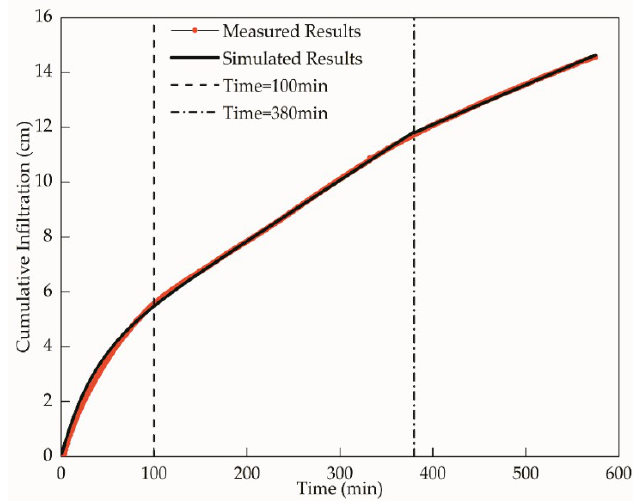
Figure 10. Simulation effect of continuous function infiltration model.